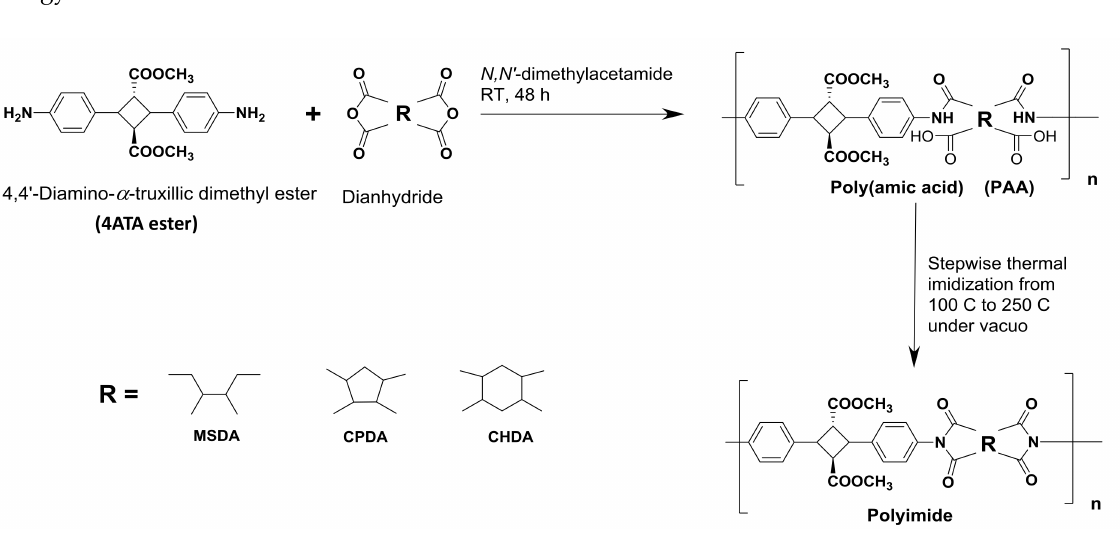
Figure 1. Polymerization scheme between 4,4 (cid:48) -Diamino- α -truxillic dimethyl ester and various